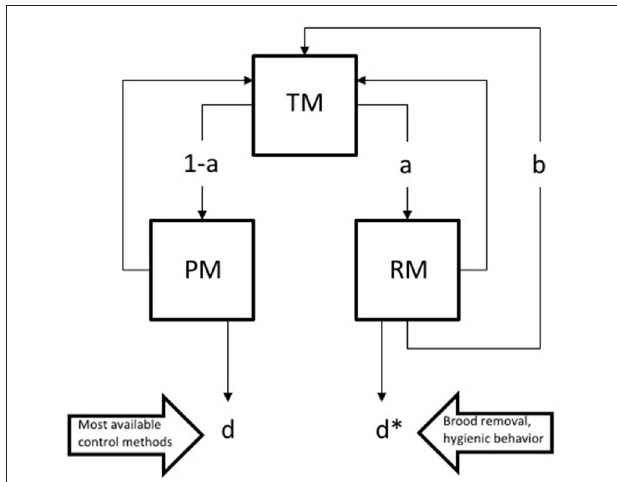
FIGURE 1 | Some dynamic implications of the life cycle of Varroa destructor . The life cycle of the parasite includes a phoretic phase on adult bees and a reproductive phase in brood cells; phoretic mites enter brood cells containing a bee larva, reproduce and emerge with the eclosing bee; after some time on adult bees, another reproductive phase is initiated. Therefore, the mite’s life cycle can be schematized as follows. A proportion “a” of the total mite population (“TM”) can enter the reproductive phase within brood cells (i.e., reproducing mites: “RM”) and reproduce at a rate “b” or die at a rate “d ∗ ”. Mites not entering a brood cell (i.e., phoretic mites: “PM”) die at a rate “d” or can later enter a brood cell to reproduce. The increase of the mite